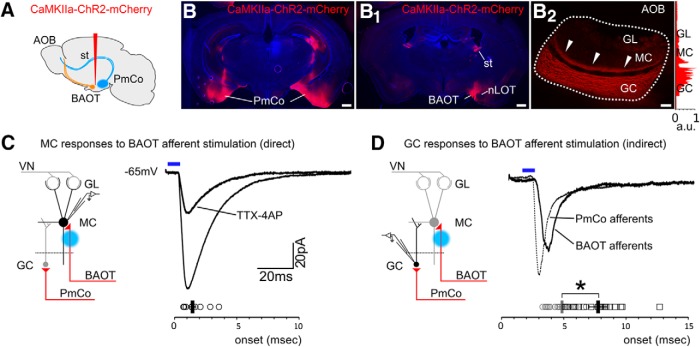
Optogenetically evoked MC excitatory responses are induced by the activation of BAOT afferents. A–B2, Spread of CaMKIIa-ChR2 virus to the BAOT results in the expression of ChR2 not only in the PmCo projection neurons but also in those in the BAOT. Infection of this region results in mCherry labeling in the AOB GC and MC layers (see color histogram on the side, indicating the localization of mCherry labeling). C, Optogenetic stimulation of the MC layer evoked excitatory responses in MCs (onset, 1.3 ± 0.2 ms; 14 cells) only when the BAOT was infected. D, These direct responses (not blocked by TTX-4AP bath application) result in disynaptic excitatory events detectable in GCs, which are slower (onset, 7.7 ± 0.4 ms; 17 cells) compared with PmCo direct inputs elicited by GC stimulation (4.8 ± 0.2 ms; 23 cells; t test, p < 0.0005; Fig. 1B).